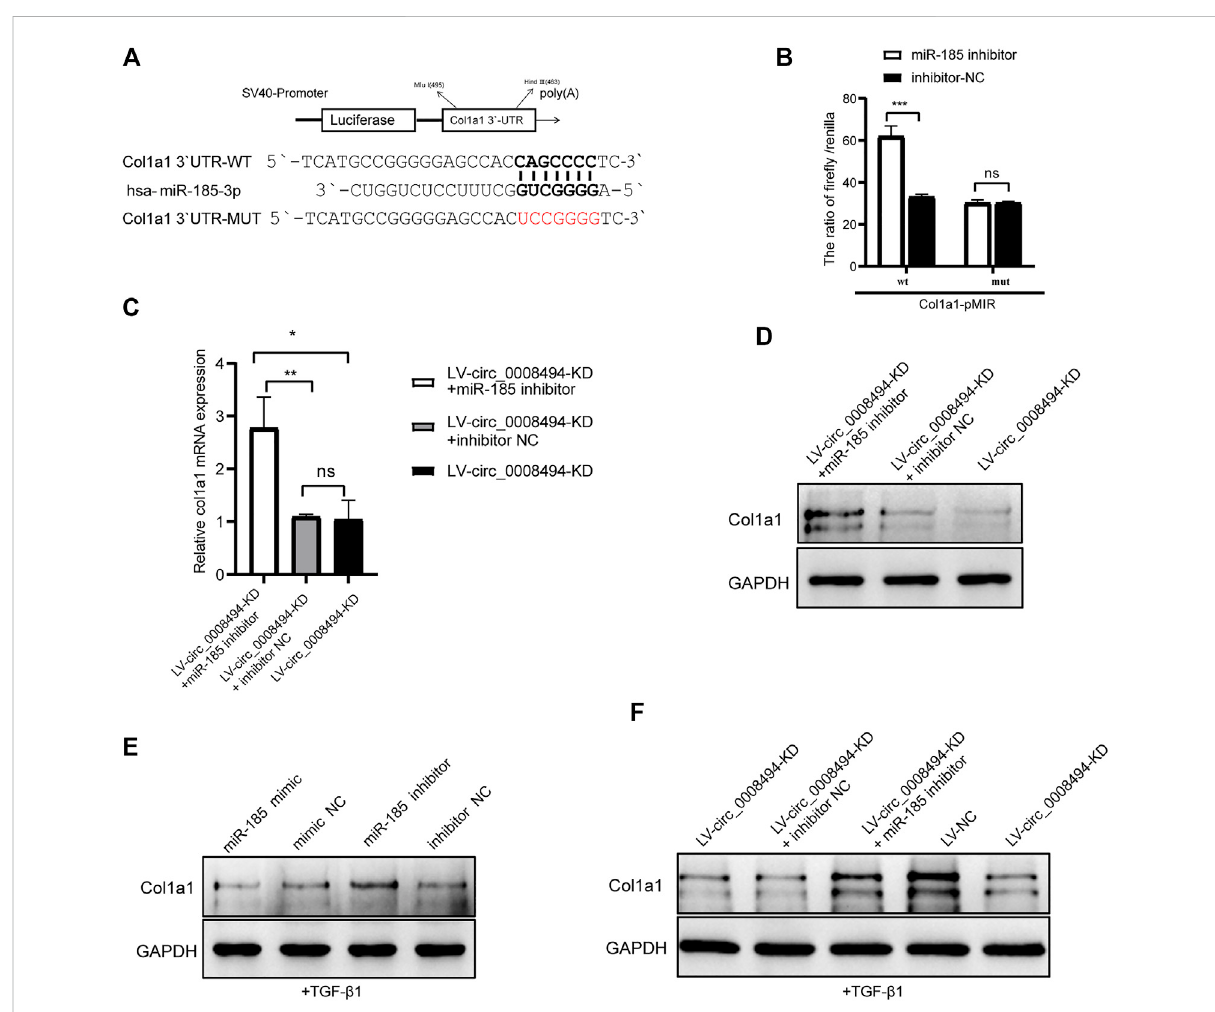
FIGURE 7 Suppressingcirc_0008494inhibitsHSCsactivationbyregulatingthemiR-185-3p/Col1a1axis (A) ThepMIR-REPORTluciferasereporterplasmid wasusedtoconstructCol1a13 ′ UTR-WT-pMIRandCol1a13 ′ UTR-MUT-pMIR.TargetScanwebsitepredictedsevenribonucleotidesofhas-miR-185- 3p were complementary to the 642 – 648 sites of Col1a1 3 ′ -UTR (B) Dual-luciferase reporter gene assay veri fi ed the binding relationship between miR-185-3p and Col1a1 (C andD) miR-185-3p inhibitor orinhibitor NCwastransfectedinto stable LV-circ_0008494-KDLX-2cells, andmRNA and protein levels of Col1a1 was detected by qRT-PCR and western blot assays (E) After TGF- β 1 stimulation, miR-185-3p inhibitor/mimic were transfected into LX-2 cells, and Col1a1 protein expression level were detected by western blot assay (F) After TGF- β 1 stimulation of stable LV- circ_0008494-KD cells or LV-NC cells, Col1a1 protein expression was detected by western blot assays. Moreover, miR-185-3p inhibitor or